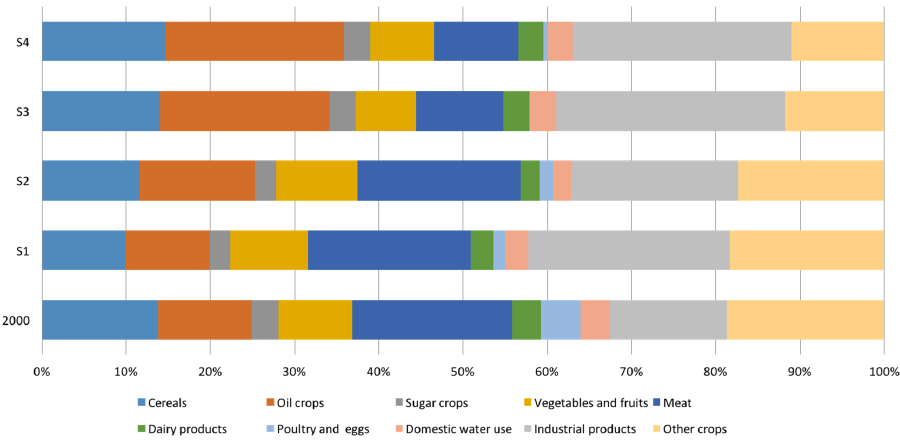
Figure 9. The composition of the total water footprint (WF) of European consumption by commodity. The blue WF of consumption in Europe is mainly due to industrial products in 2050 (Figure 10).